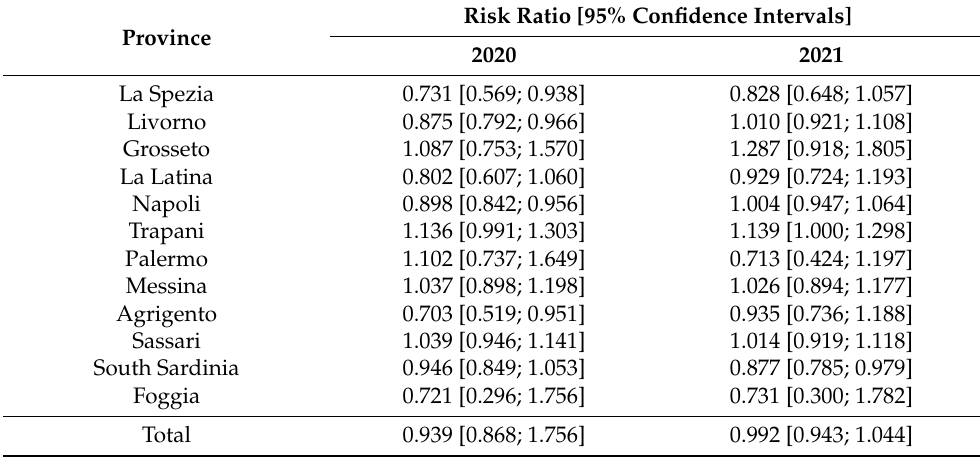
Table 4. Risk Ratio for all-cause mortality on Italian small islands in 2020 and 2021 compared to parent provinces, assuming estimates for 2018–2019 as a